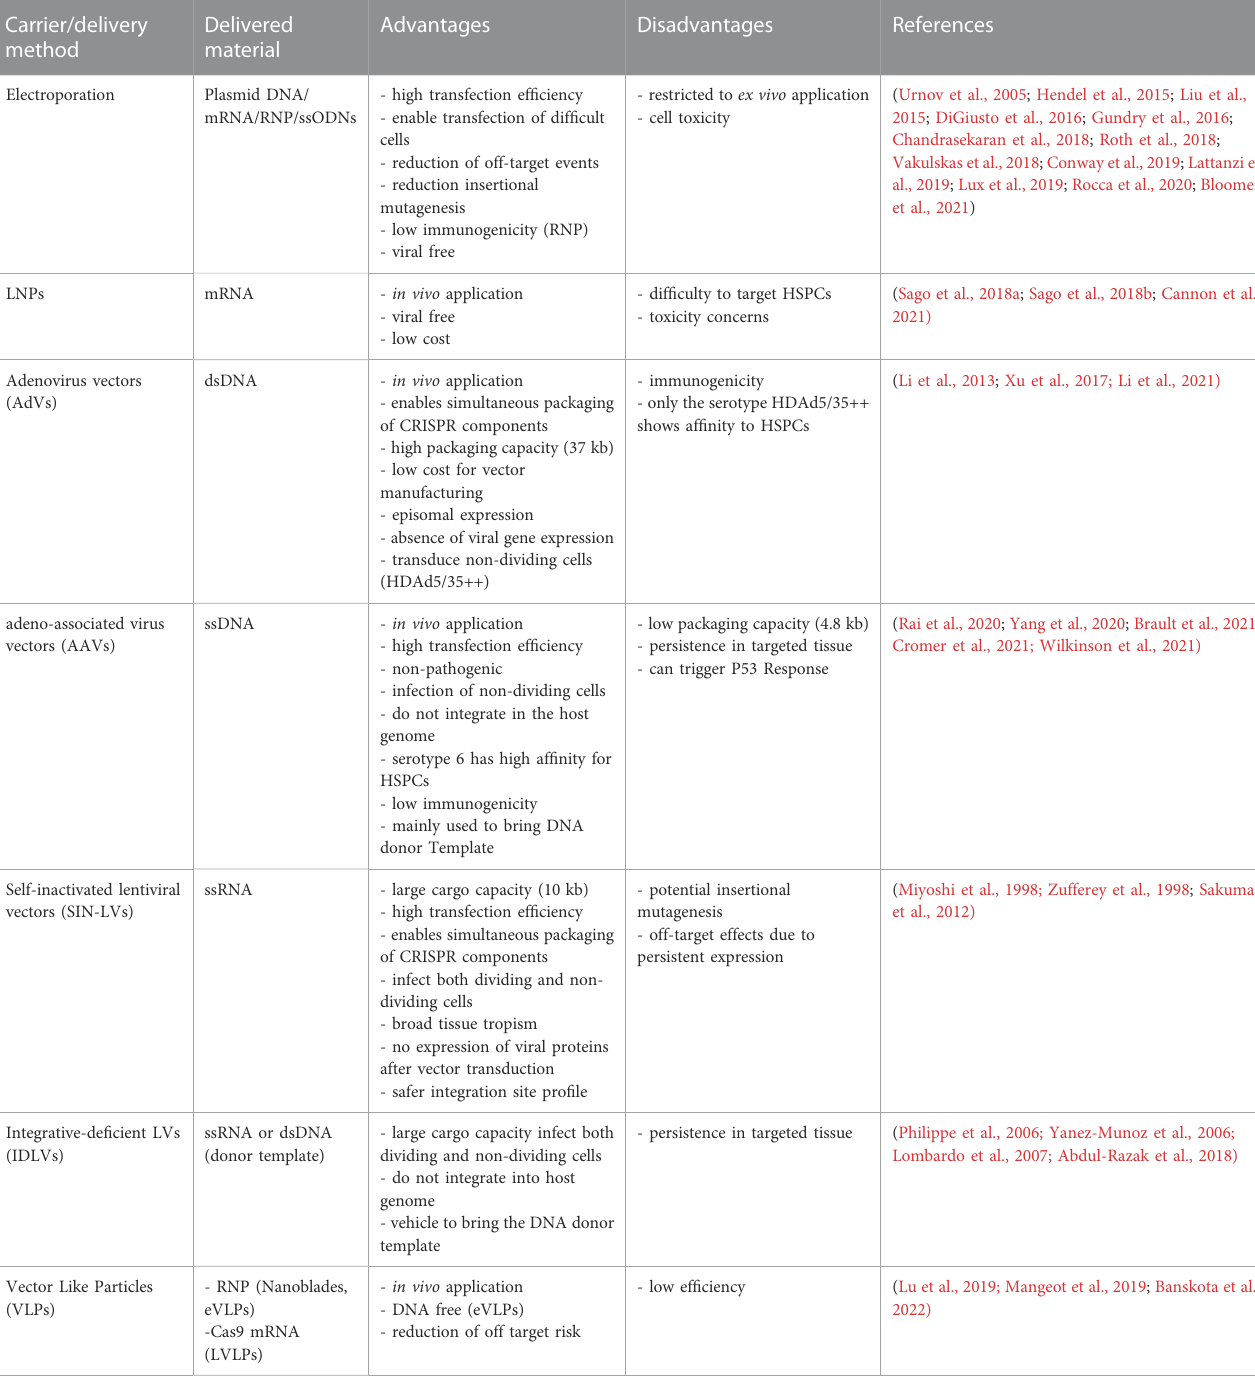
TABLE 1 Delivery method comparison for gene